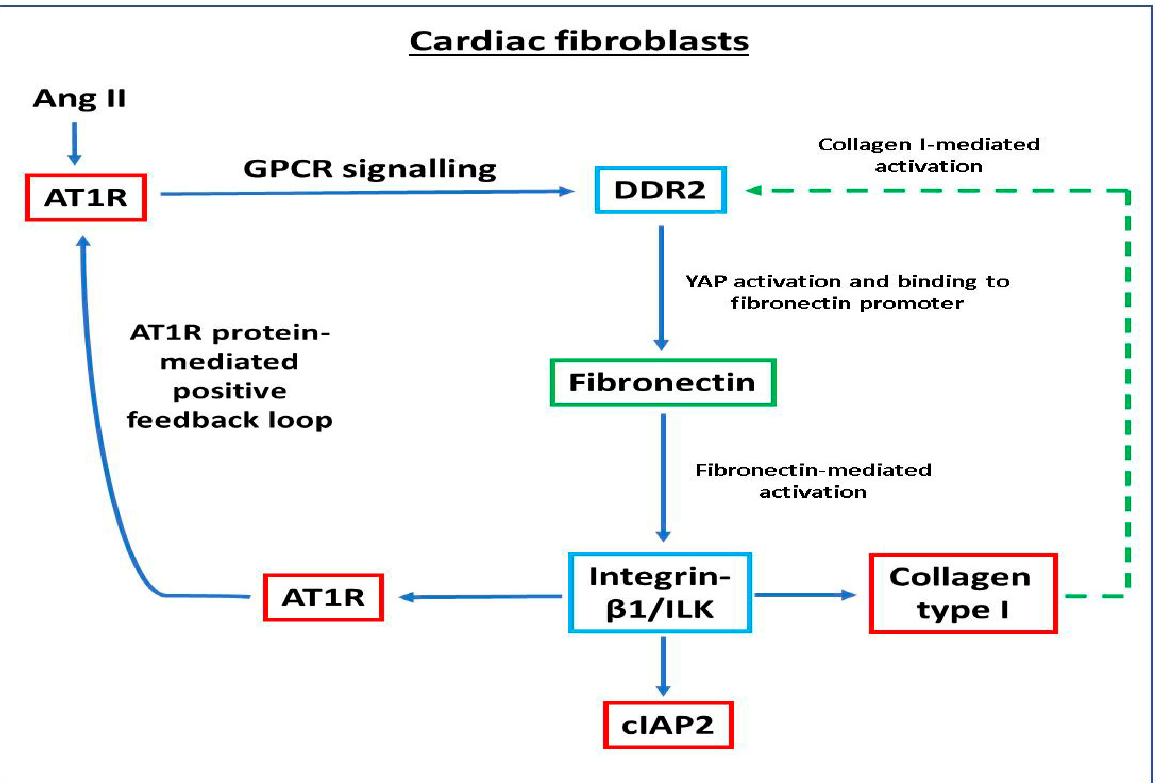
Figure 7. Schematic representation of the molecular events that link ECM and Ang II signaling pathways in cardiac fi- broblasts.